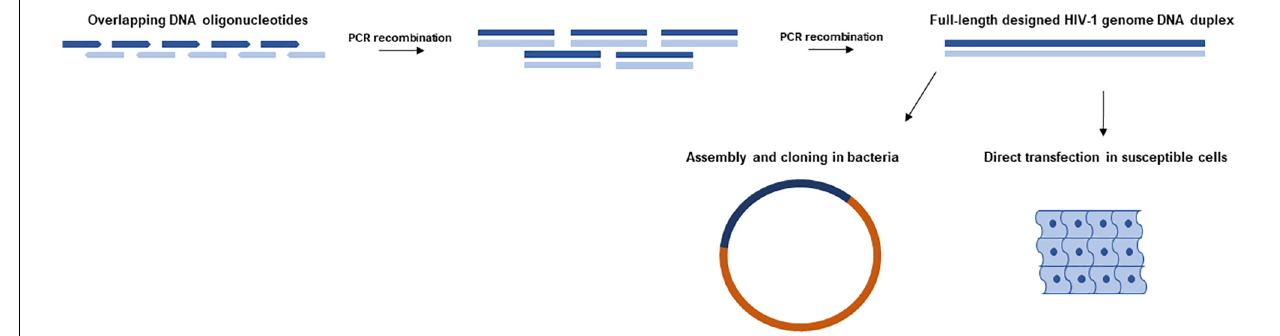
FIGURE 1 | Synthetic HIV-1 DNA oligonucleotide assembly and cell transfection. Overlapping oligonucleotides encoding a full-length HIV-1 genome DNA duplex are successively assembled via PCR or isothermal amplification. The designed HIV-1 DNA duplex can then be directly transfected into susceptible cells (e.g., MT-4 and PBMCs) to yield infectious virus (Fujita et al., 2013). Alternatively, synthetic HIV-1 DNA can be cloned in bacteria or other vectors for further manipulation.